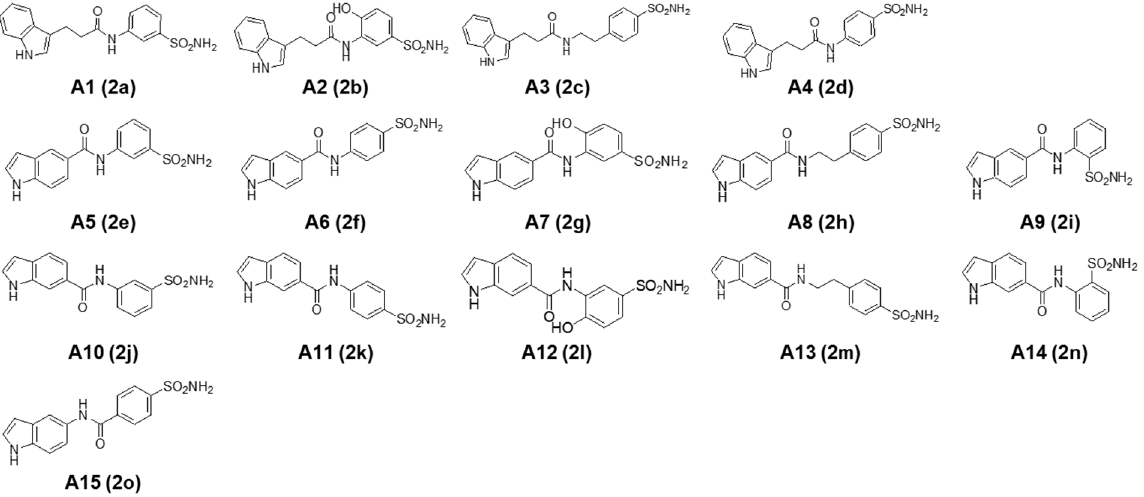
Figure 1. Chemical structures of indole-based benzenesulfonamides ( A1 − A15 ). The compound codes ( 2a − 2o ) reported to be potent carbonic anhydrase inhibitors [20] are also provided in parentheses.